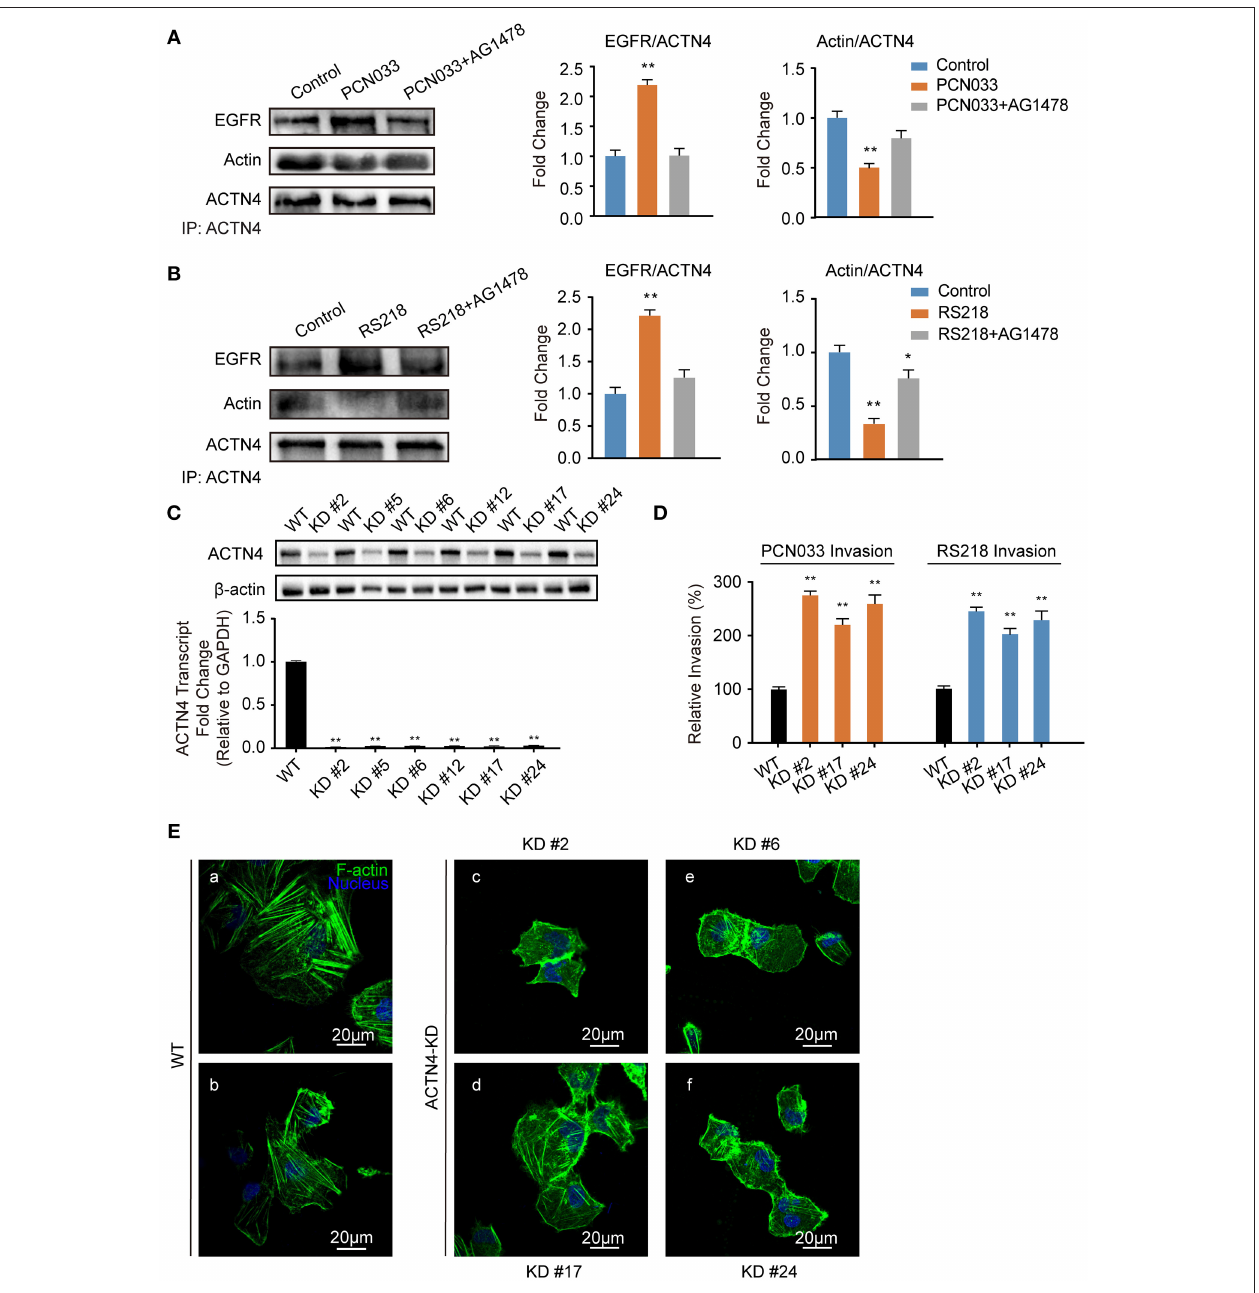
FIGURE 5 | Meningitic E. coli -induced EGFR recruitment of ACTN4 is important for bacterial invasion. (A,B) The meningitic E. coli PCN033- (A) or RS218-induced (B) activation of EGFR results in increased recruitment of ACTN4 to EGFR and decreased binding of ACTN4 to F-actin, while inhibition of EGFR by AG1478 reversed this alteration. The densitometry results represent the ratio of EGFR to ACTN4 as well as F-actin to ACTN4. (C) Quantitative PCR and western blotting verification after ACTN4 genetic manipulation via CRISPR/Cas9. (D) Effect of the ACTN4 knock-down on meningitic E. coli PCN033 or RS218 invasion. Results are presented as the relative invasion percentage compared with that of the wild-type cells. (E) Effect of the ACTN4 knock-down on cell cytoskeleton morphology via confocal fluorescence microscopy. * p < 0.05, ** p < 0.01.